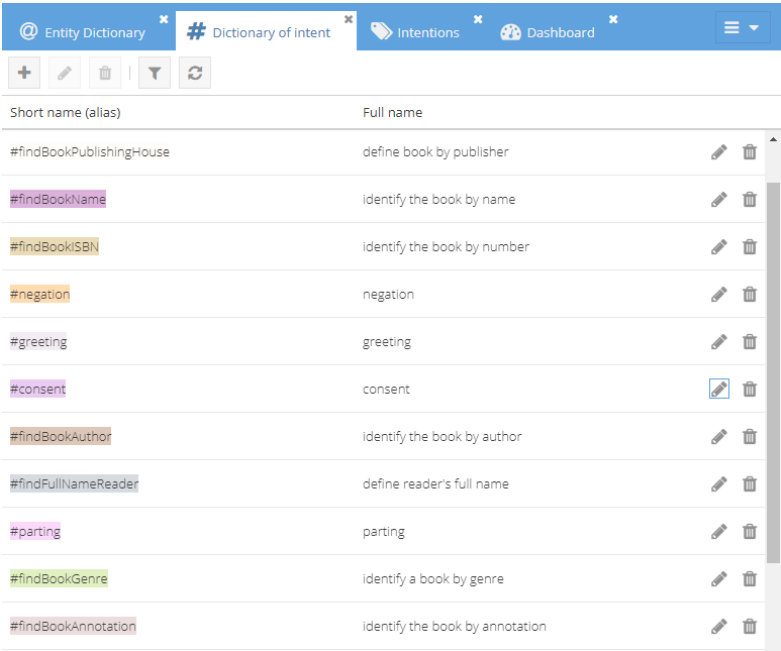
Fig. 2. The intent of the text analysis software agent for the